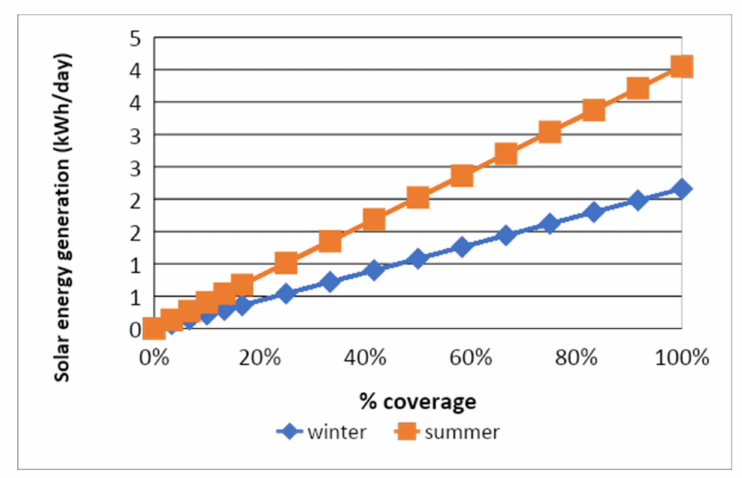
Figure 5. Solar energy generation by solar panels vs. percentage coverage of Sheikh Zayed Canal for the 50-km length of the Canal.